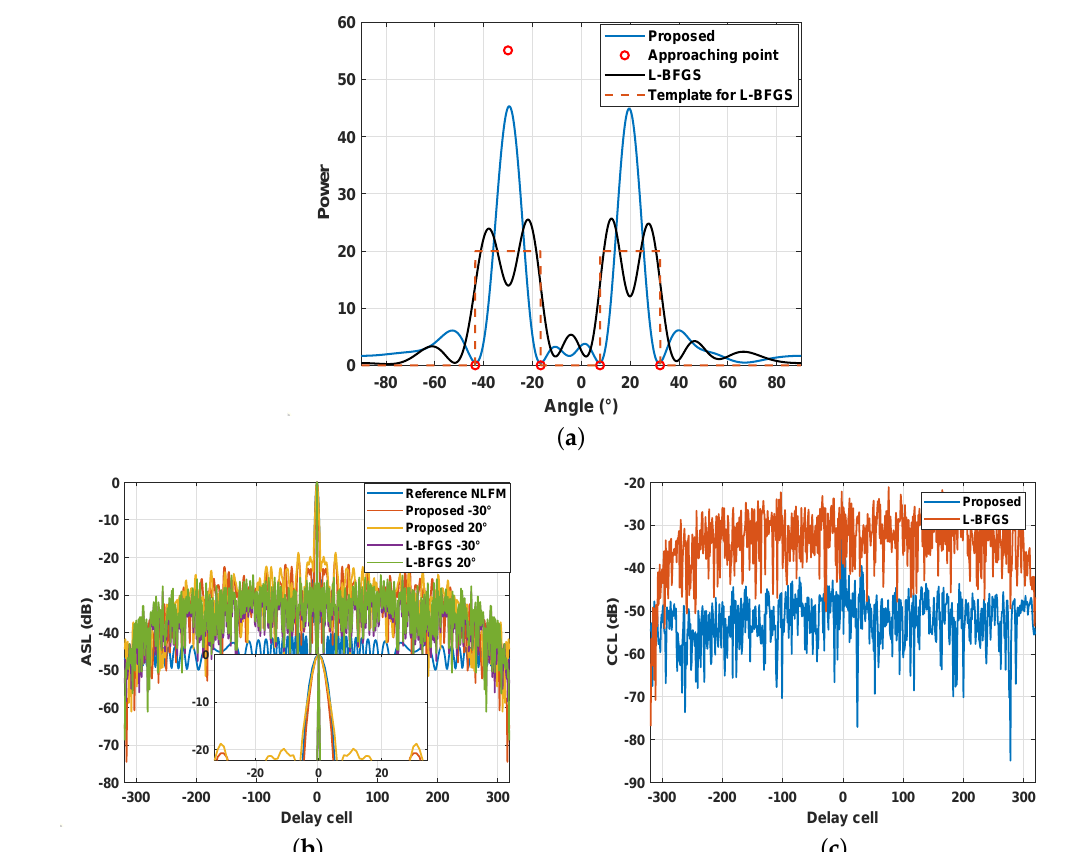
Figure 13. The results for the proposed method and the L-BFGS. ( a ) The transmit beampattern. ( b ) The ASL of AWs. ( c ) The CCL of AWs at − 30 ◦ .